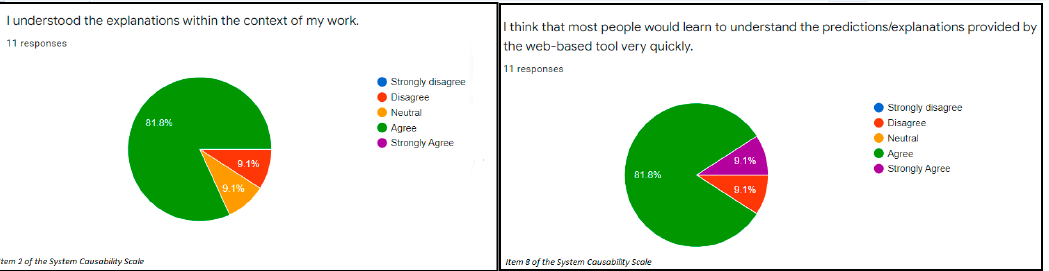
Figure 2. The explainability of a web-based prognostic tool using items number 2 and 8 of the System Causability Scale.